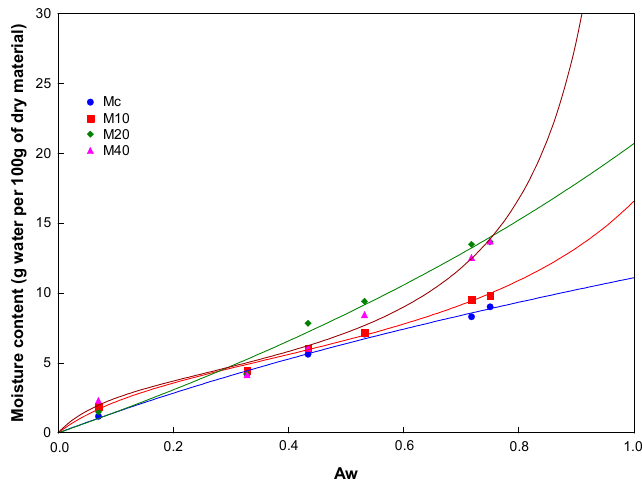
Figure 2. Moisture adsorption isotherms at 30 °C for MXs with different DP. The continuous line indicates the regression according to the GAB model.